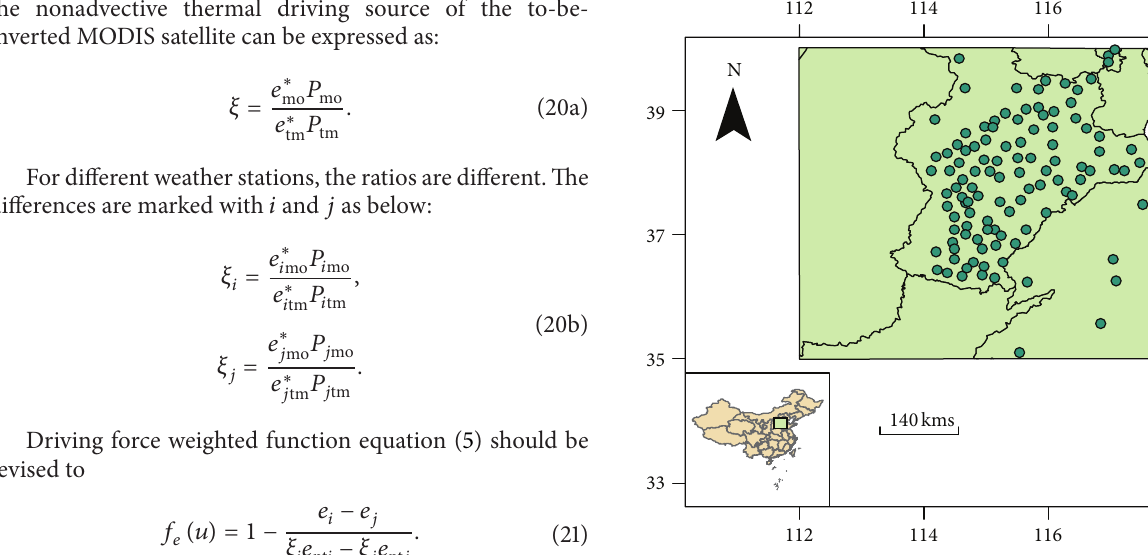
Figure 1: Weather station distribution in North China